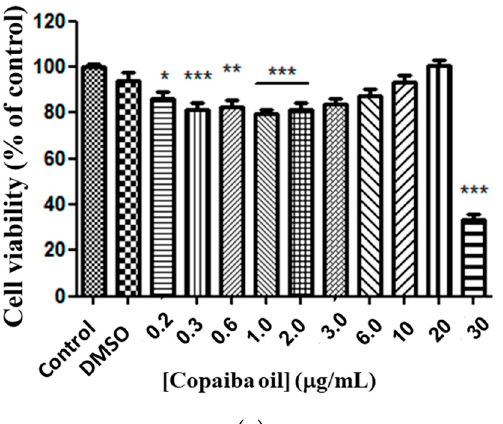
Free CP showed moderate toxicity against the glioma cell line at doses from 0.2 to 2.0